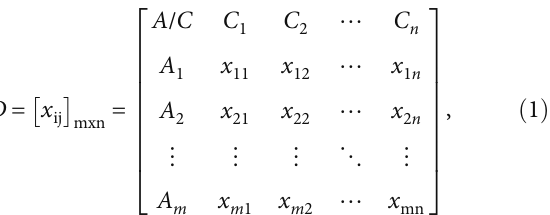
Figure 2: Geometric interpretation of the median M = ð